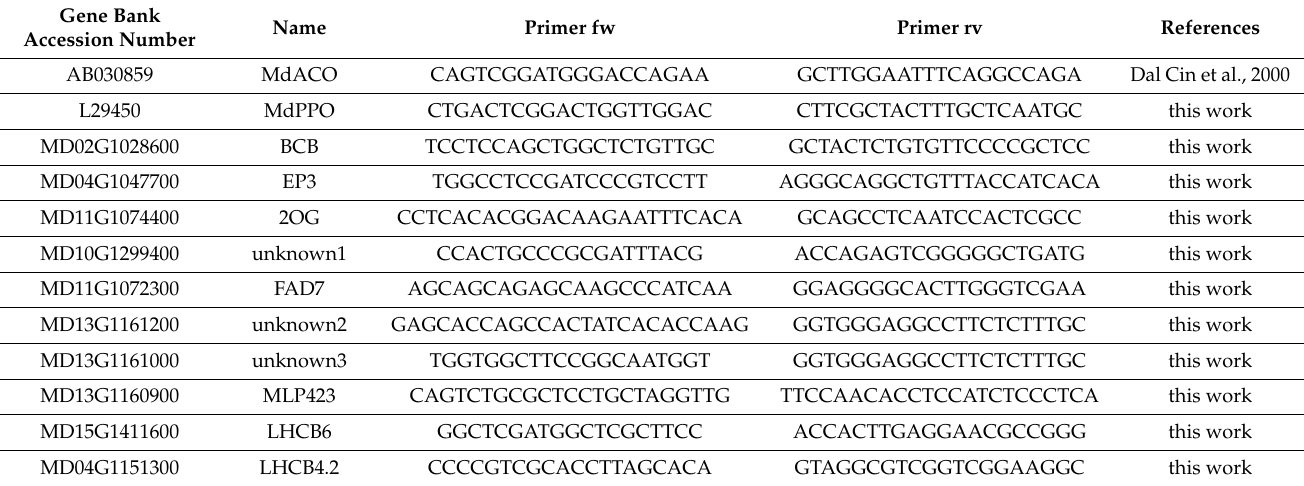
Table 3. Primer sequences used for targeted Real-Time PCR expression analysis on MdACO and MdPPO , known as ripening marker genes, and of RNA-Seq identified DEGs. ACO, 1-aminocyclopropane-1-carboxylate oxidase—ACC oxidase; PPO, Polyphenol oxidase; BCB, blue-copper-binding protein; EP3, Endochitinase EP3; 2OG, 2-oxoglutarate (2OG) and Fe(II)- dependent oxygenase superfamily protein; FAD7, fatty acid desaturase 7; MLP423, Major latex-like protein 423, LHCB6, light harvesting complex photosystem II subunit 6; LHCB4.2, light harvesting complex photosystem II subunit